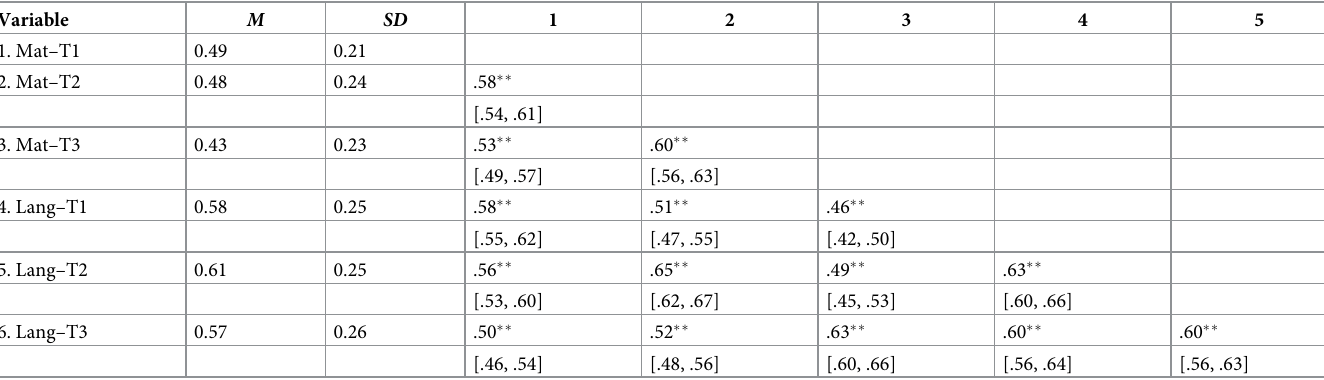
Note . M and SD are used to represent mean and standard deviation, respectively. Lang–results in language (three waves), Mat–results in mathematics (three waves). Values in square brackets indicate the 95% confidence interval for each correlation. The confidence interval is a plausible range of population correlations that could have caused the sample correlation (Cumming, 2014). � indicates p < .05. �� indicates p < .01.